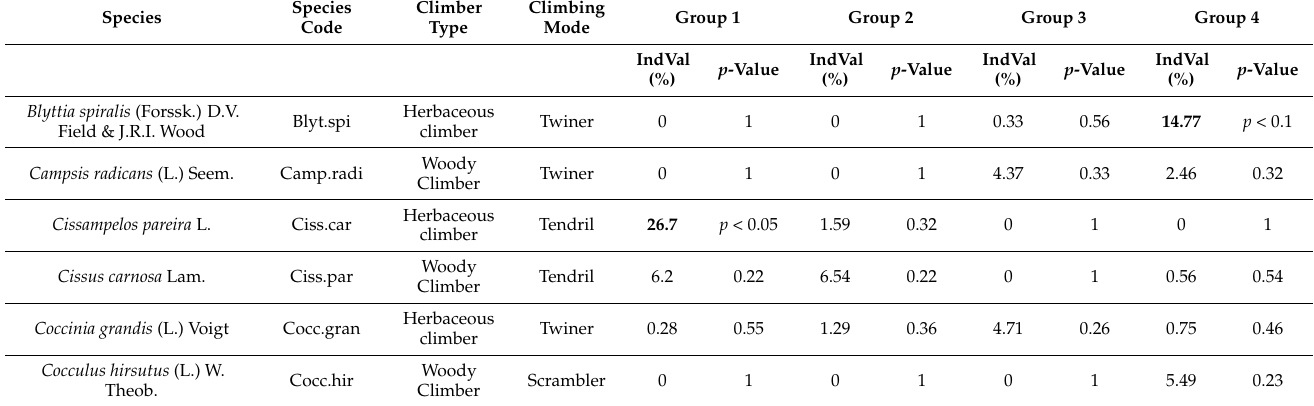
Table 1. List of plants, climbing habits, and indicator species analysis of climbers in four groups of Ward’s cluster analysis in the Changa Manga Forest Plantation. The individual value as a percentage and indicator p -values of each recorded species of four groups are shown in the table. The individual values (%) of indicator species in each group are highlighted in